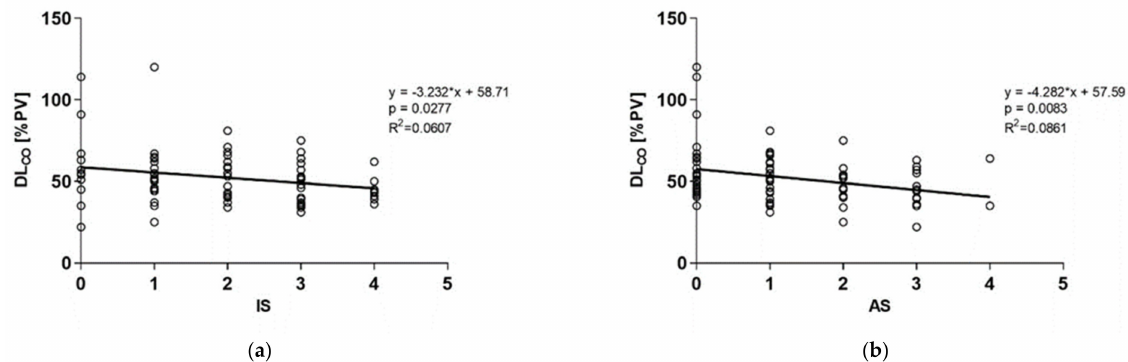
Figure 4. Correlations between HRCT scores and DL CO in all pathologies tested together: ( a ) negative correlation between IS and DL CO ; ( b ) negative correlation between AS and DL CO ; IS—interstitial score; AS—alveolar score; DL CO —diffusing lung capacity for carbon monoxide; PV—predicted